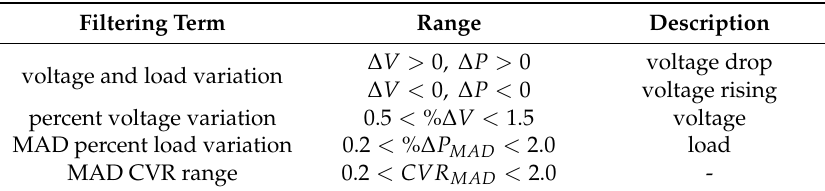
Table 4. Filtering conditions for estimating CVR factor of load